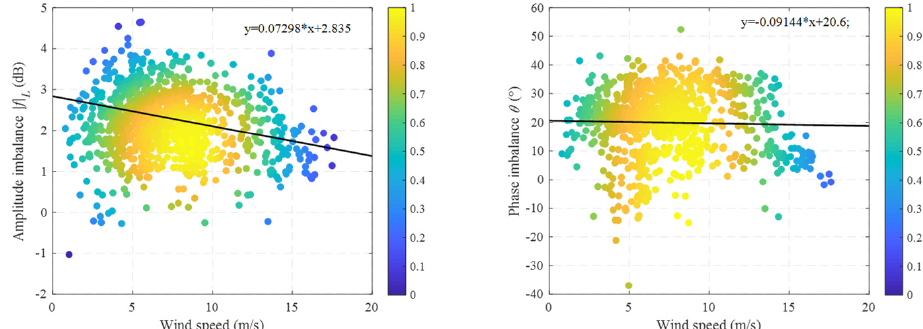
Figure 6. The empirical fitting result of amplitude and phase imbalance relative to wind speed.